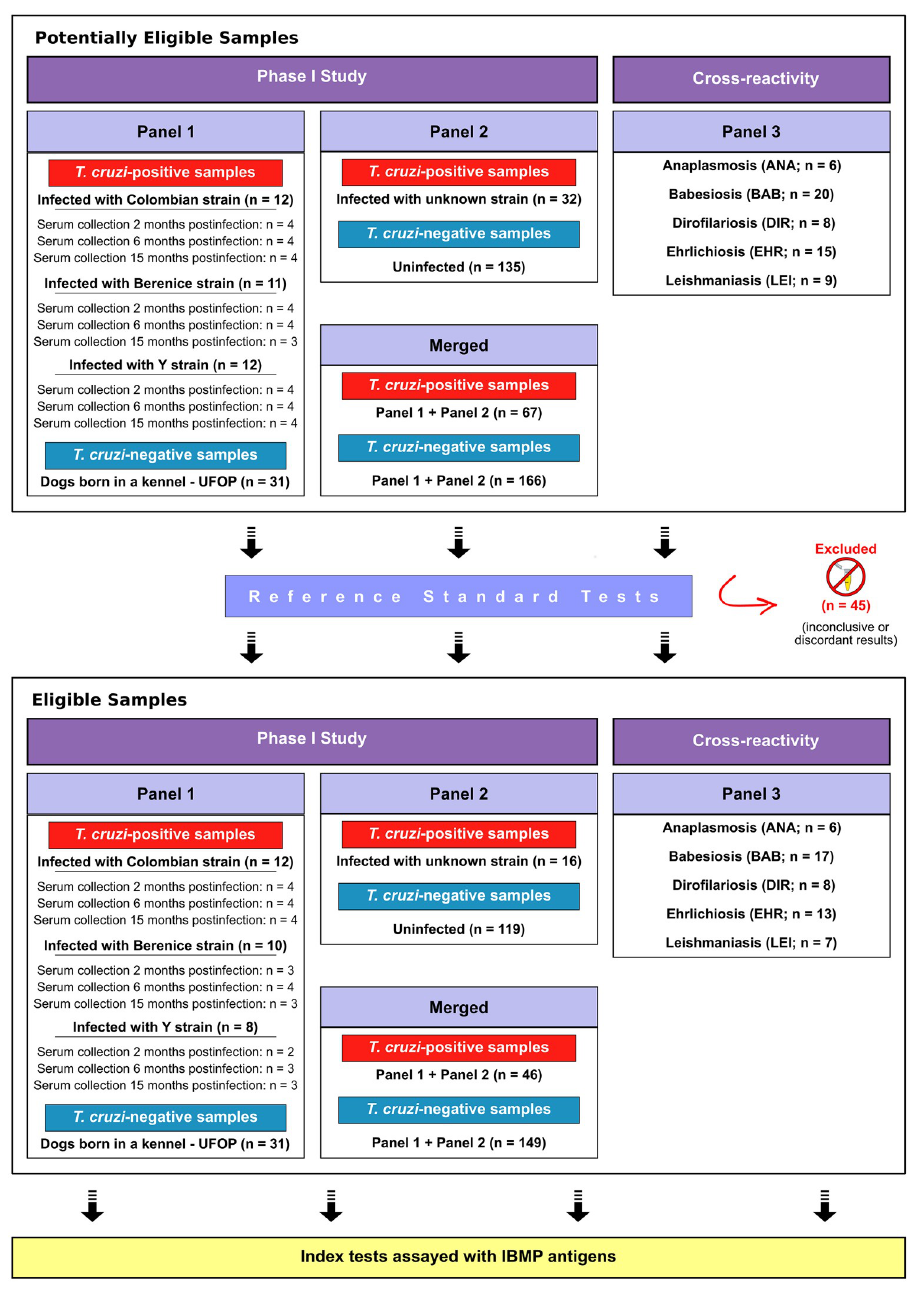
Fig 2. STARD flowchart to evaluate the diagnostic performance of IBMP chimeric antigens to detect anti- Trypanosoma cruzi antibodies in dog sera. Reference Standard Tests: in-house ELISA using fractionated lysates of T . cruzi at the epimastigote and modified Gold ELISA Chagas (Rem Indu´stria e Come´rcio, Brazil).